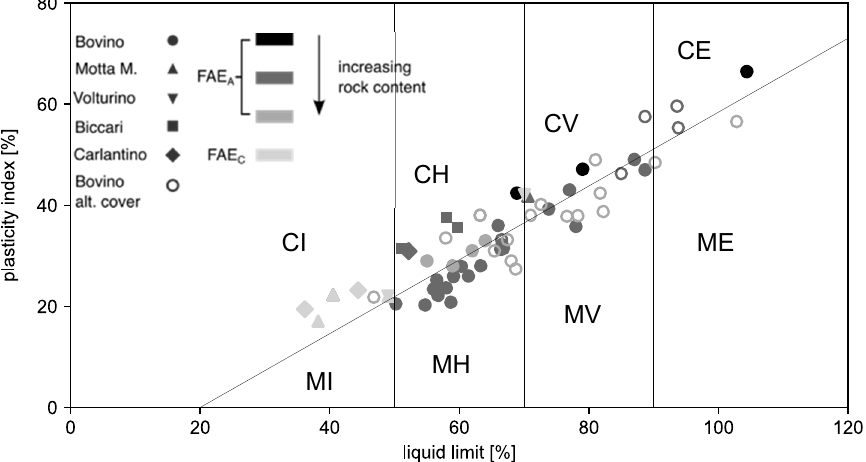
Figure 14. Classification of Faeto Flysch: standard plasticity chart [53].